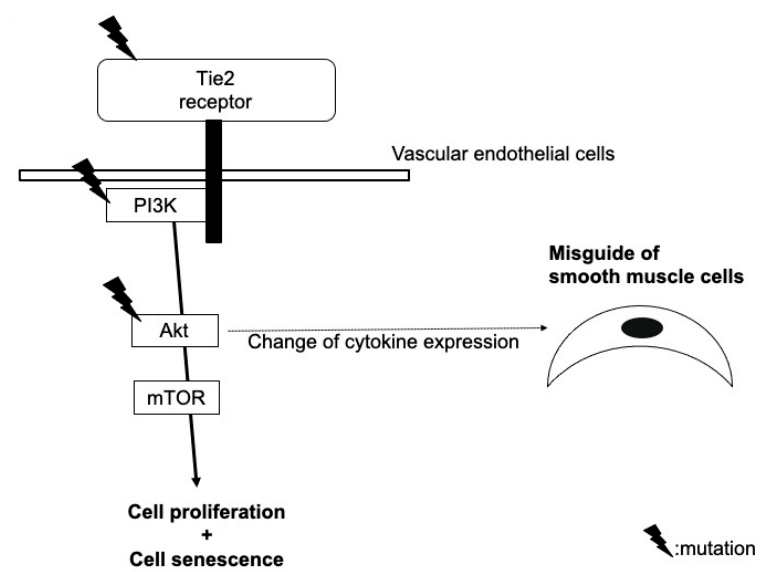
Figure 2. Our hypothetical model of the role of mutations in Tie2, PIK3CA, and Akt in the pathogen- esis of venous malformation.